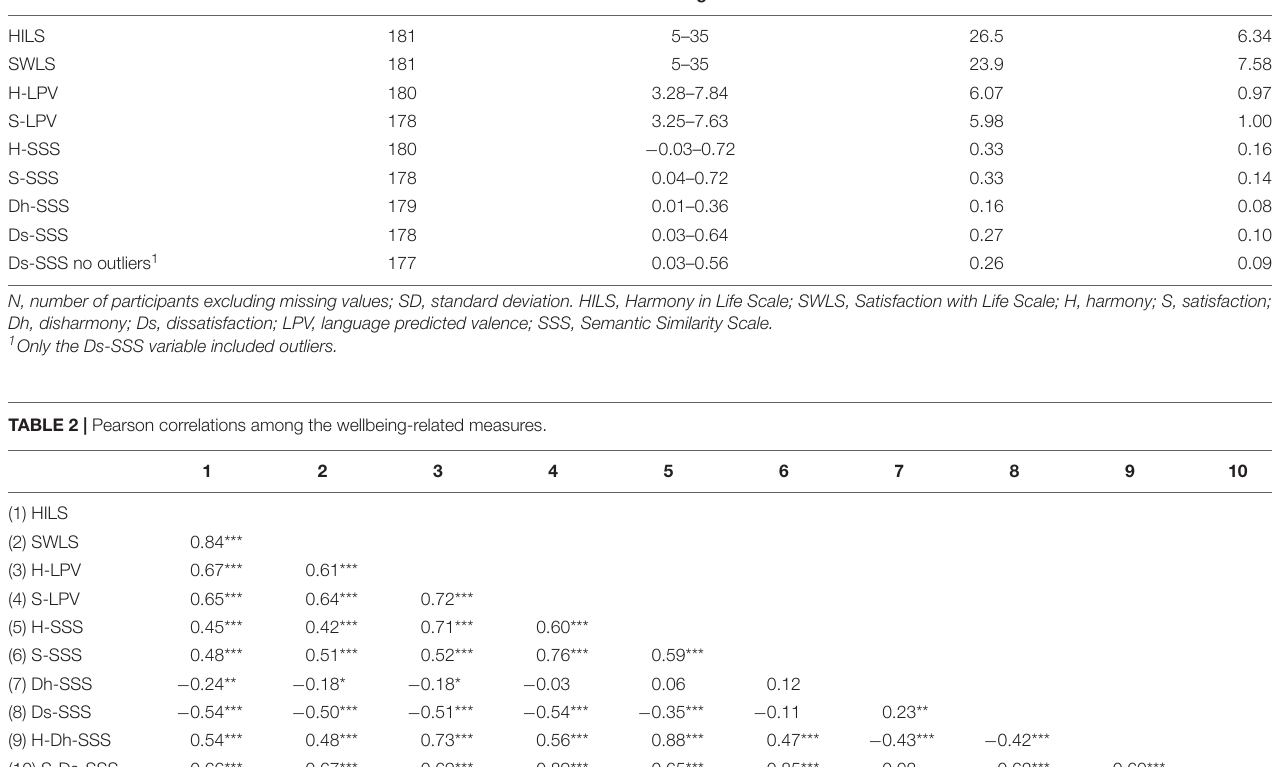
TABLE 1 | The number of participants excluding missing values, the range, the mean, and the standard deviation before and after outliers were removed for each variable. Measure N